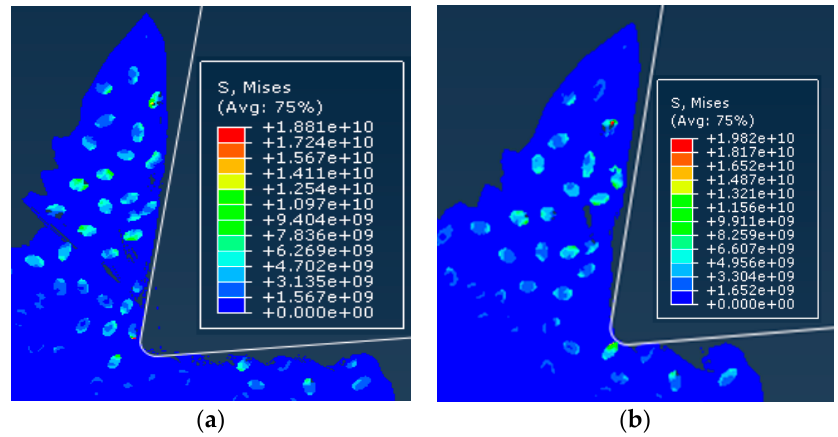
Figure 23. Comparison of stress distribution of different cutting speed examples: ( a ) v c = 100 m/min, ( b ) v c = 200 m/min.